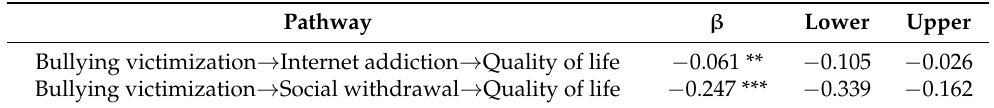
Table 4. Standardized indirect effect and 95% CI. Pathway β Lower Upper Bullying victimization → Internet addiction → Quality of life − 0.061 ** − 0.105 − 0.026 Bullying victimization → Social withdrawal → Quality of life − 0.247 *** − 0.339 − 0.162 ** p < 0.01; *** p <